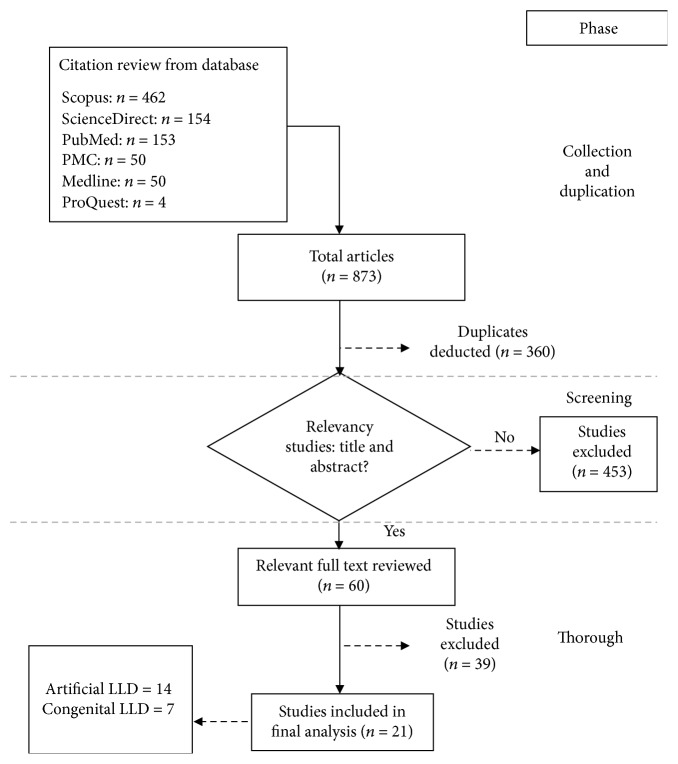
Flowchart procedure showing the study selection process from reviewed papers.